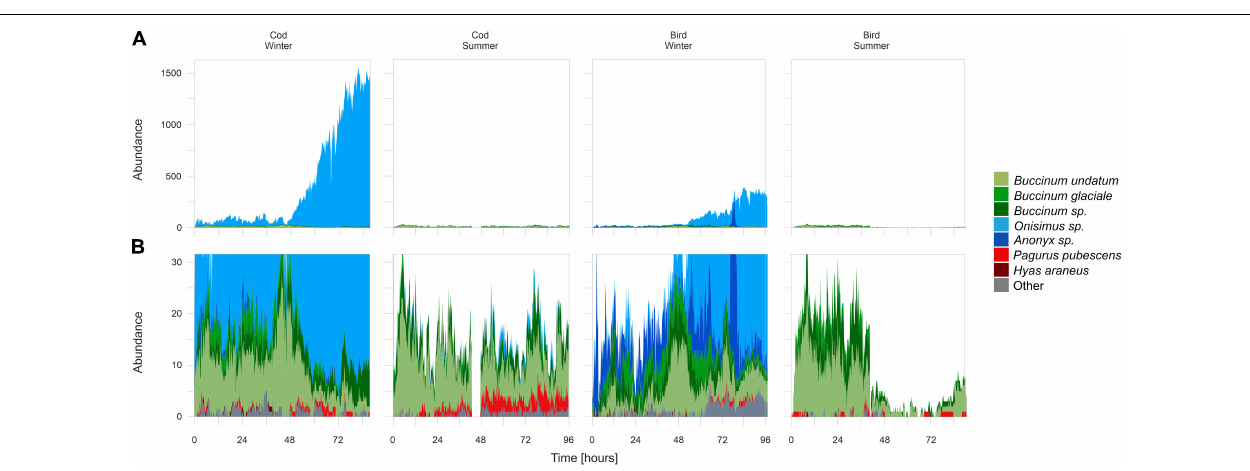
FIGURE 4 | Number of individuals observed at each bait type in each season: with scale including all the Onisimus sp. counted (A) with scale reduced to 30 individuals (allowing other taxa to be seen more clearly) (B) . Gaps in the continuity of data over time are caused by lack of data due to obstruction of the camera’s lens by kelp being dragged in front of the camera by